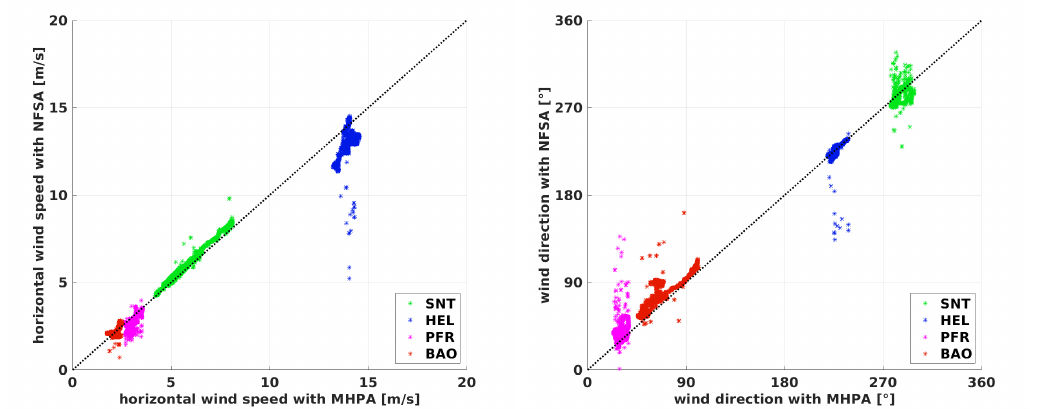
Figure 10. Comparison of the horizontal wind speed ( left ) and the wind direction ( right ) on a window of 4 min for the flights at the Boulder Atmospheric Observatory (BAO), Schnittlingen (SNT), Helgoland (HEL), and Pforzheim (PFR). The black dashed line shows the bisecting line where the multi-hole-probe algorithm (MHPA) equals the no-flow-sensor algorithm (NFSA). The data is calculated on a window with M = 240 s. The results from the MHPA are plotted against the results from the NFSA